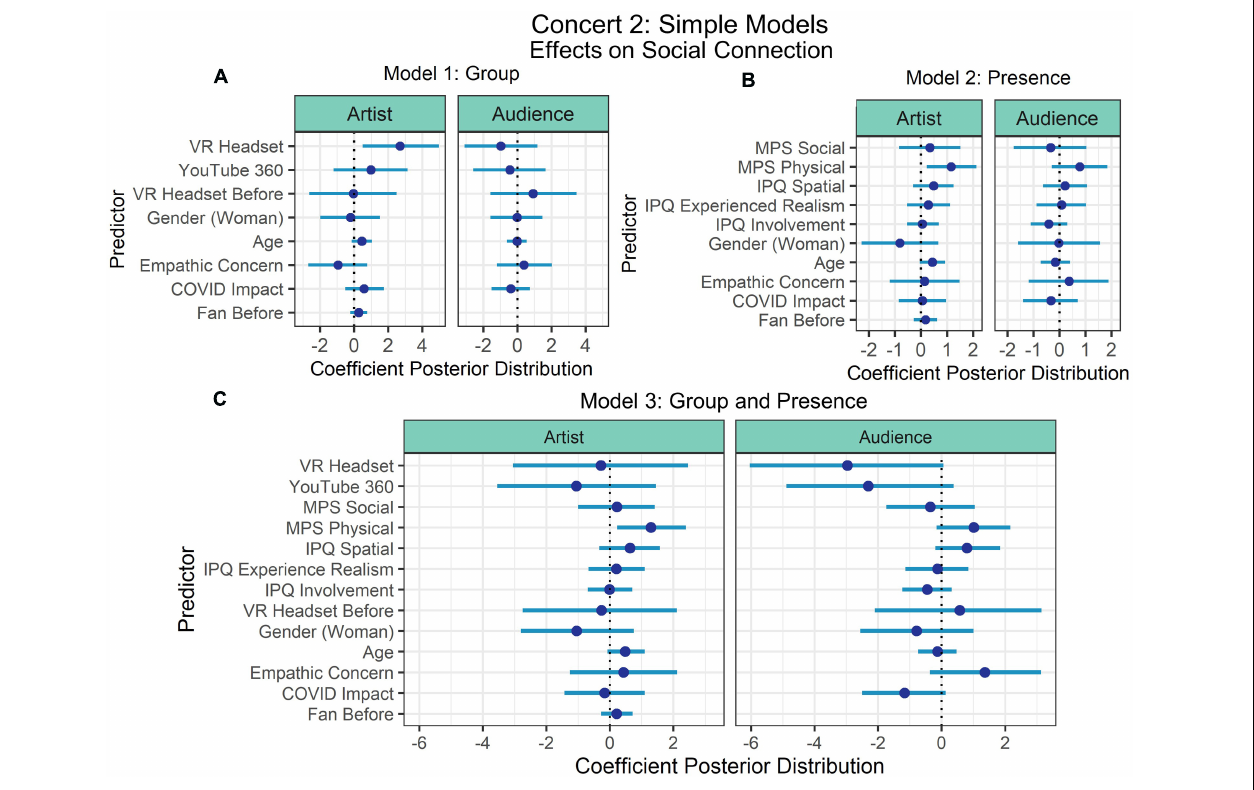
FIGURE 5 | Concert 2’s simple models’ predictor coefficient estimates (points) and 90% credible intervals (lines) for the effects on social connection to the artist (left) and audience (right). Three models were fit to examine the individual effects of (A) Group and (B) Presence, and the third model examined the combined effects of Group and Presence (C)